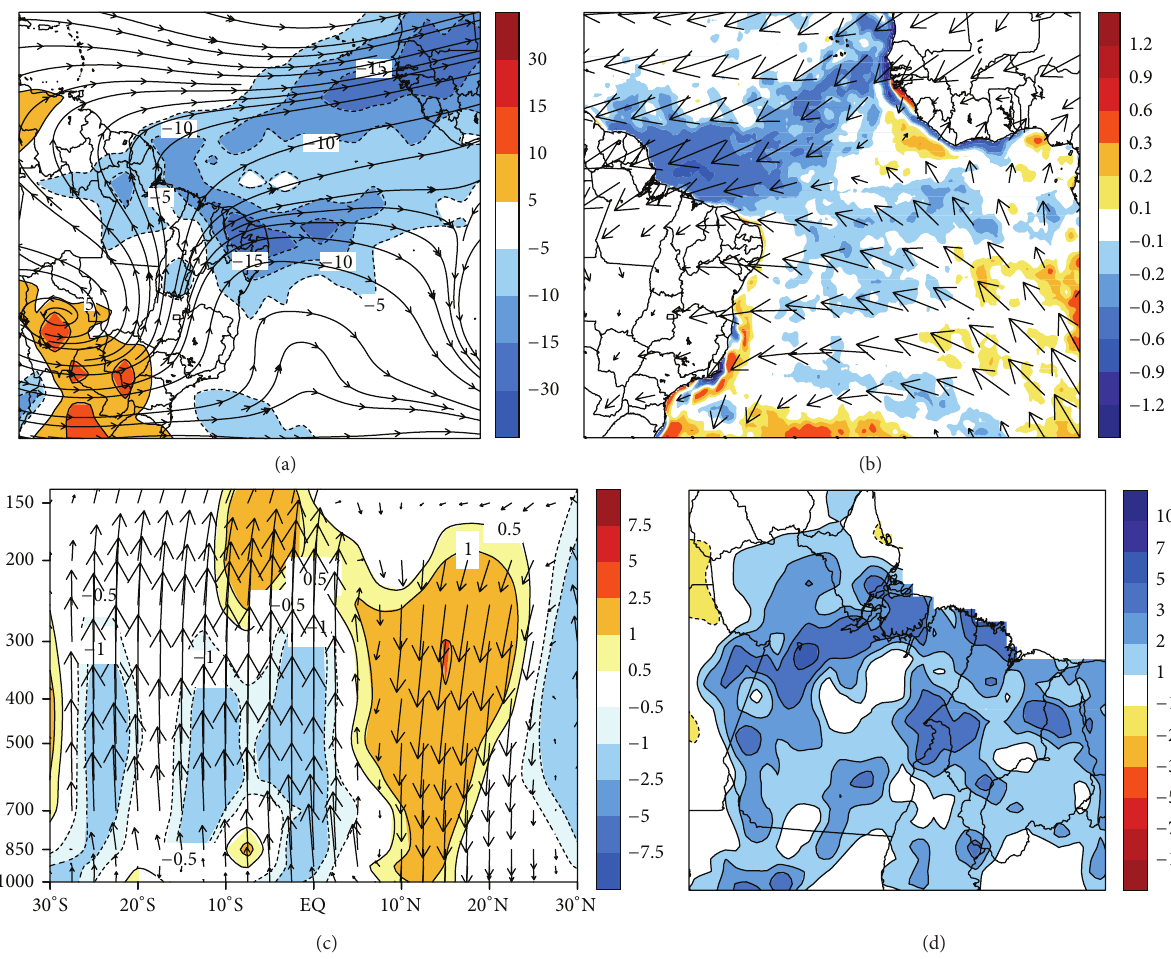
Figure 4: Composites for February (a) OLR anomalies in (W/m 2 ) and wind at 200 hPa (stream lines), (b) SST anomalies (shaded in ∘ C) and wind at 925 hPa (vectors m/s), (c) tropospheric circulation of Hadley in 050 ∘ W and Omega anomalies in colors, and (d) rainfall anomalies (mm/pentad), corresponding to the objectively selected events in the